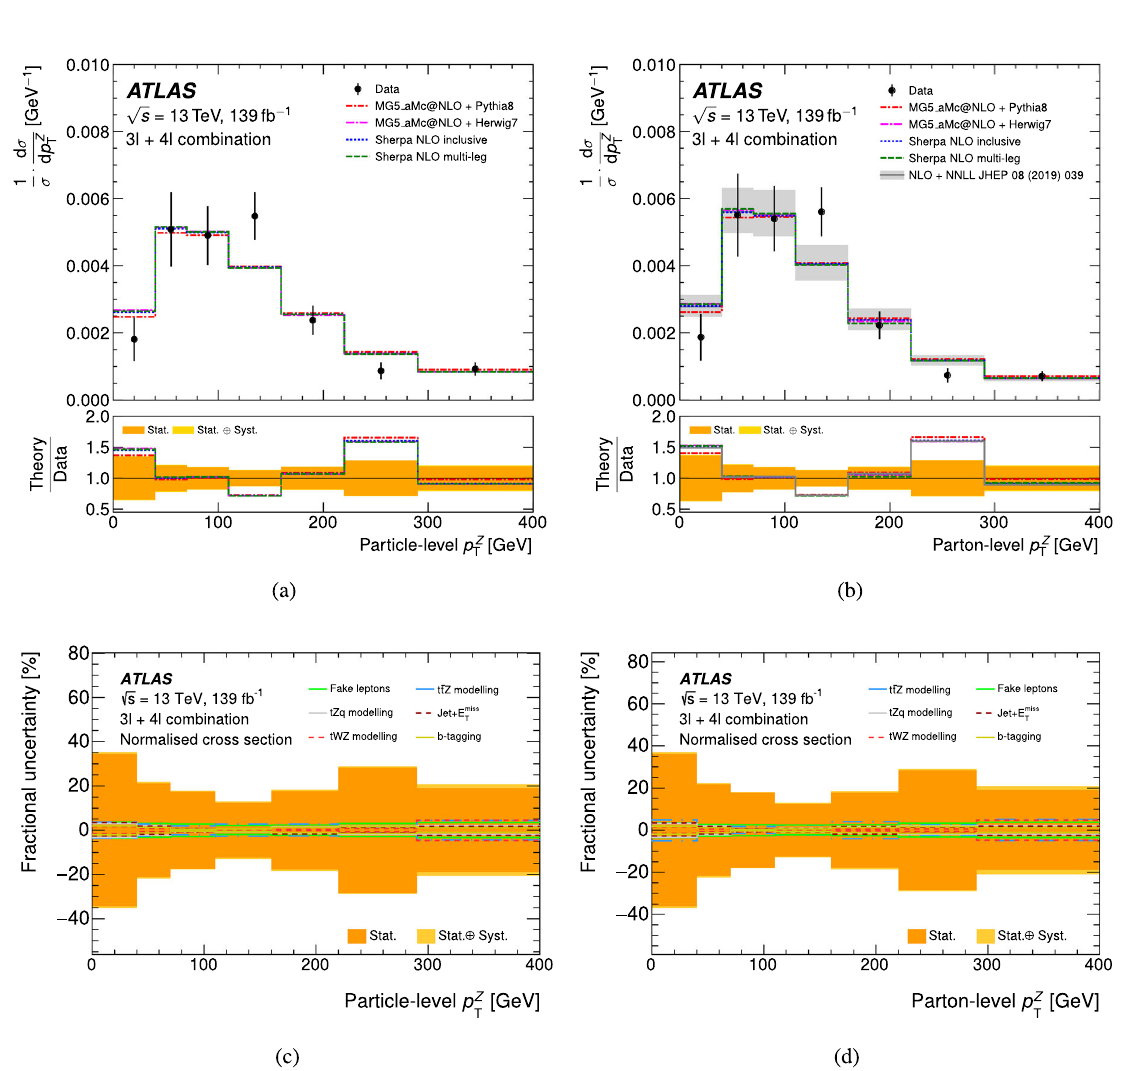
Fig. 10 Normalised differential t ¯ tZ cross sections measured at a particle level and b parton level as a function of the transverse momentum of the reconstructed Z boson. c , d Show the relative contributions from different categories of systematic uncertainties per